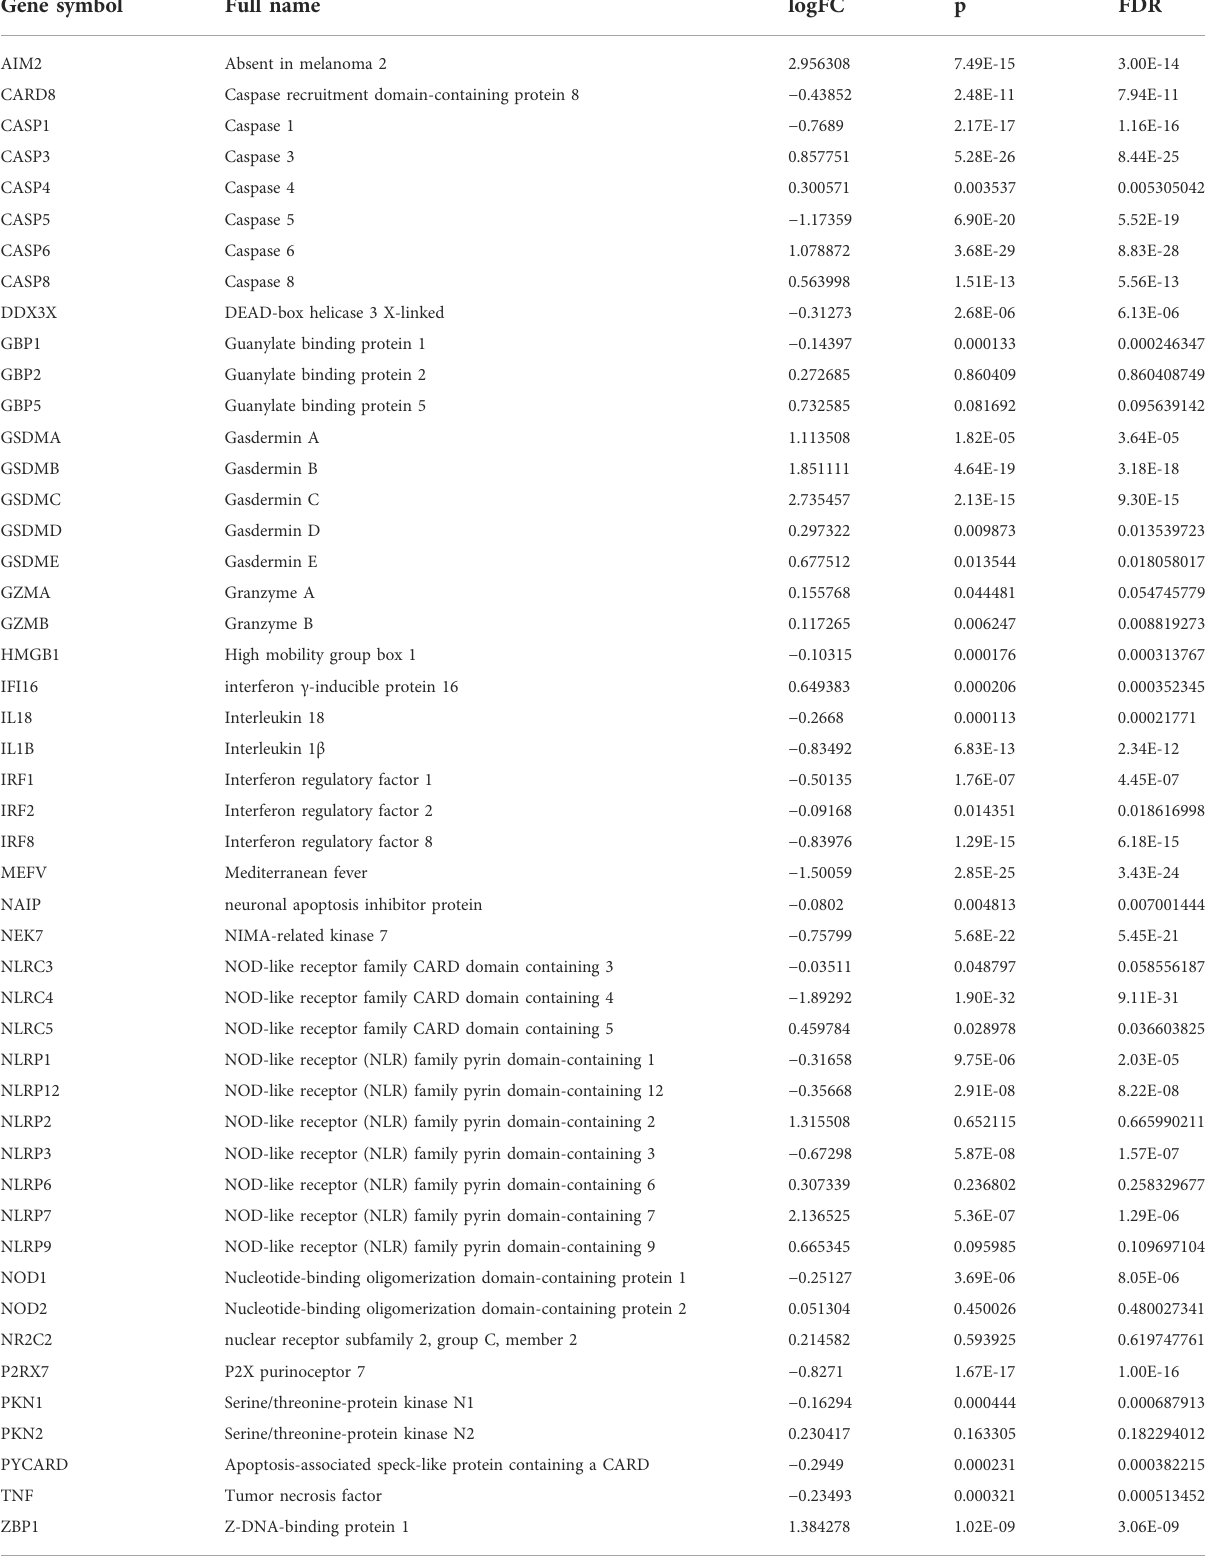
TABLE 1 Differences in expression of pyroptosis-related genes between LUAD and normal